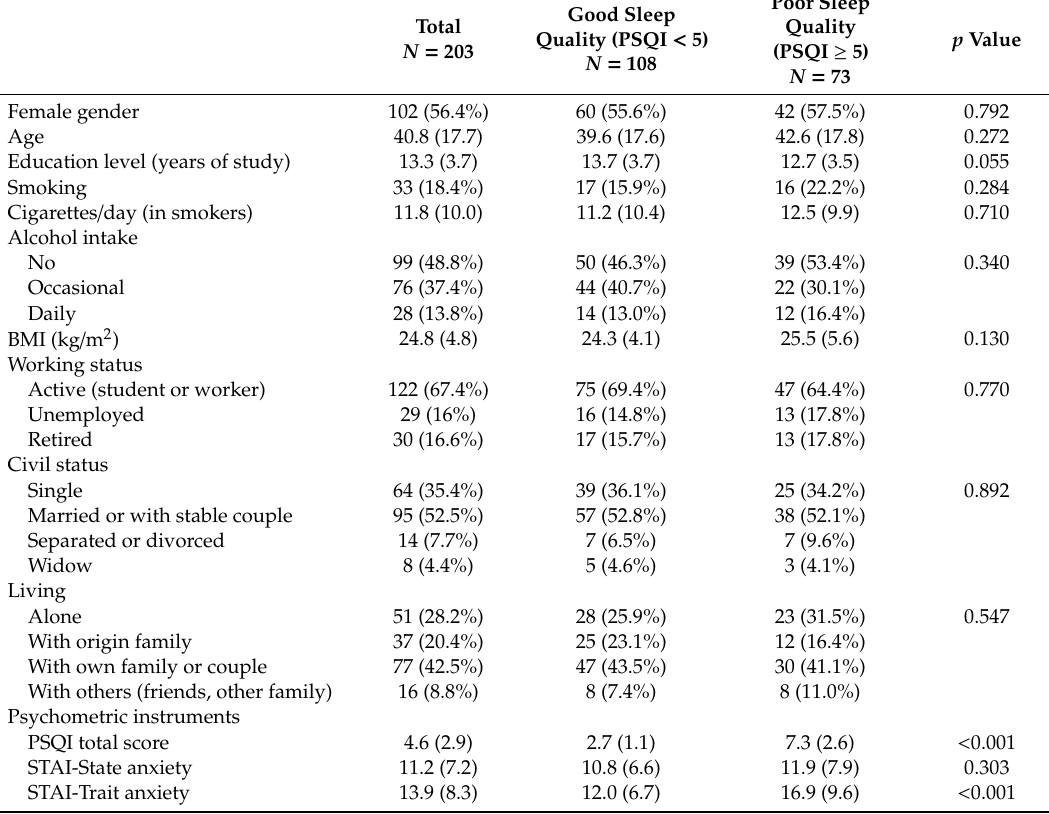
Table 1. Sociodemographic and clinical data of the sample by sleep quality groups. Total N =